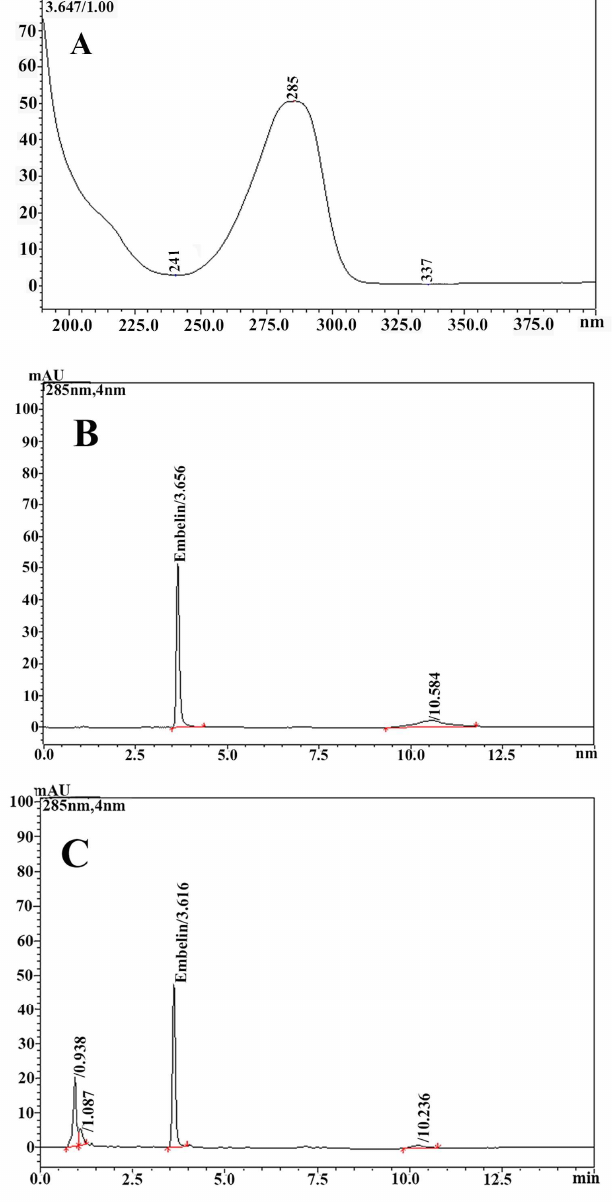
Figure 2. UV spectrum at 200–400 nm of standard embelin ( A ), HPLC chromatograms determined at 285 nm of standard embelin at a concentration of 20 µ g / mL (RT = 3.66 min) ( B ), and HPLC chromatogram determined at 285 nm of A. elliptica fruit extract at a concentration of 1 mg / mL (retention time (RT) = 3.62 min) ( C ).